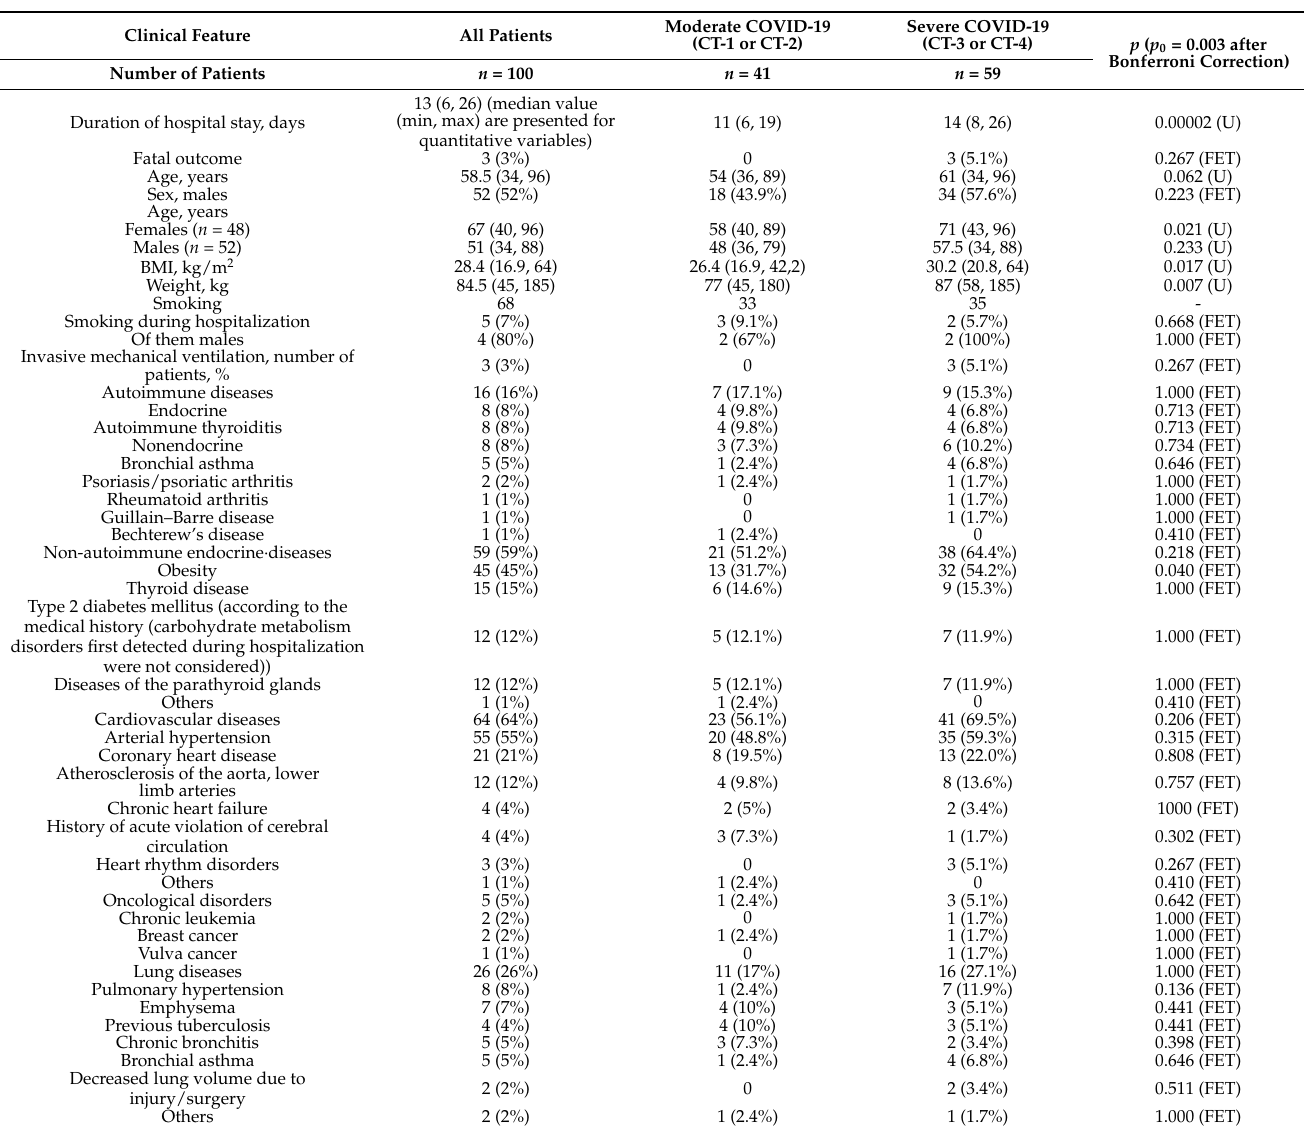
Table 1. Diagnostic and anamnestic data of patients included in the study (data on several patients were not available due to an inaccuracy in the collection of